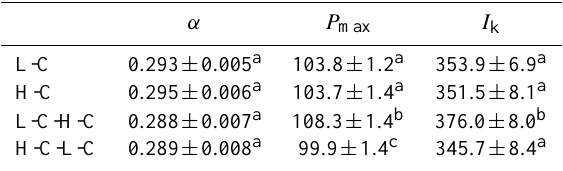
Table 2. The rapid light curve fitted parameters (i.e., α , the appar- ent photochemical efficiency; P max , maximal rETR; I k , the light saturation point) for low and high CO 2 grown cells, respectively. Derived from Fig. 4, superscripts represent significant difference among treatments.